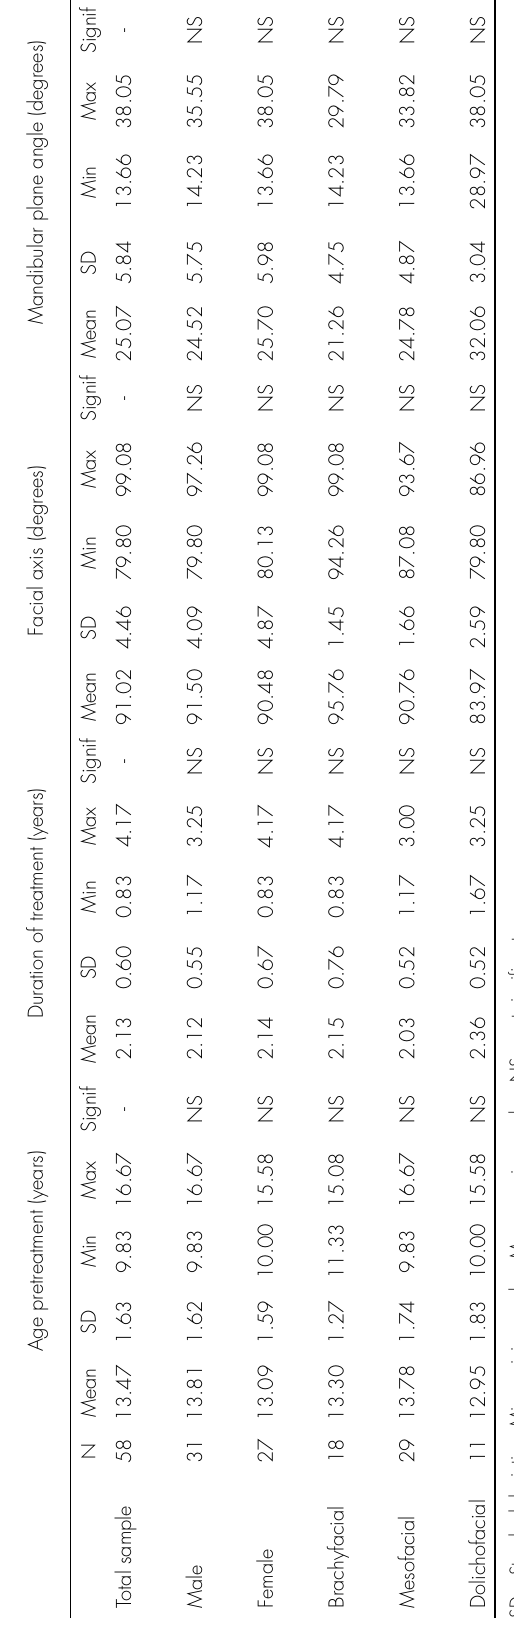
Table II. Cephalometric and study cast